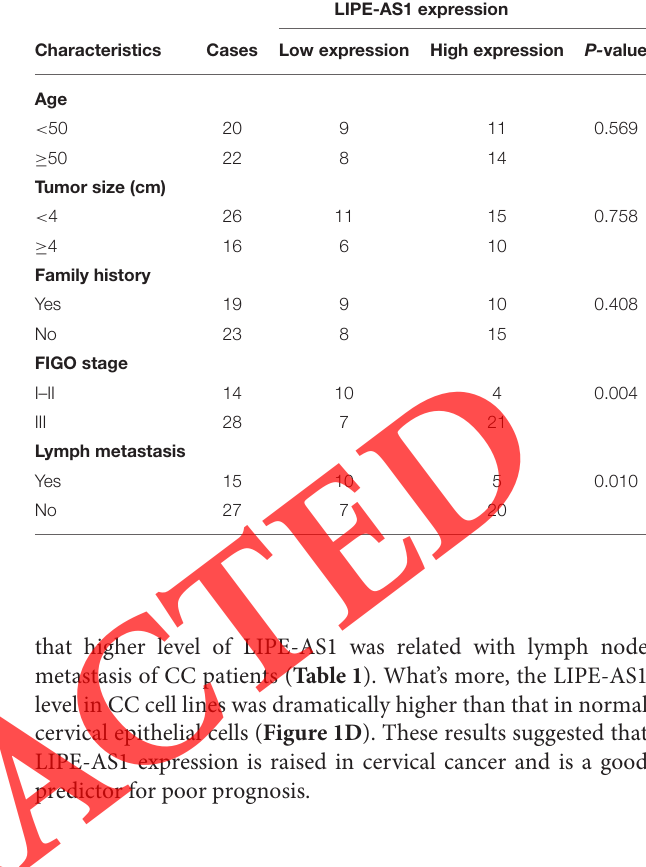
TABLE 1 | Correlation between LIPE-AS1 expression and clinicopathological characteristics in cervical cancer patients. LIPE-AS1